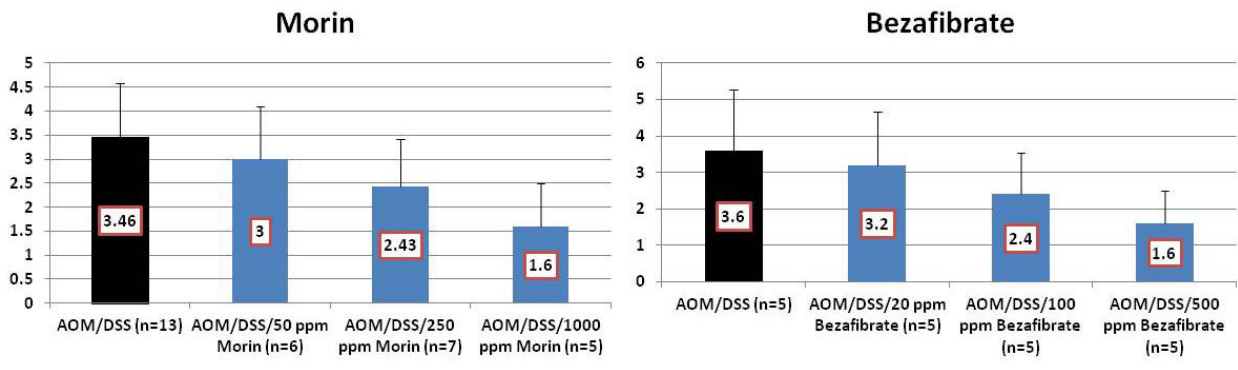
Figure 10. mRNA expression of TNF- α in the colorectum of mice or rats from the morin, bezafibrate, and VPA